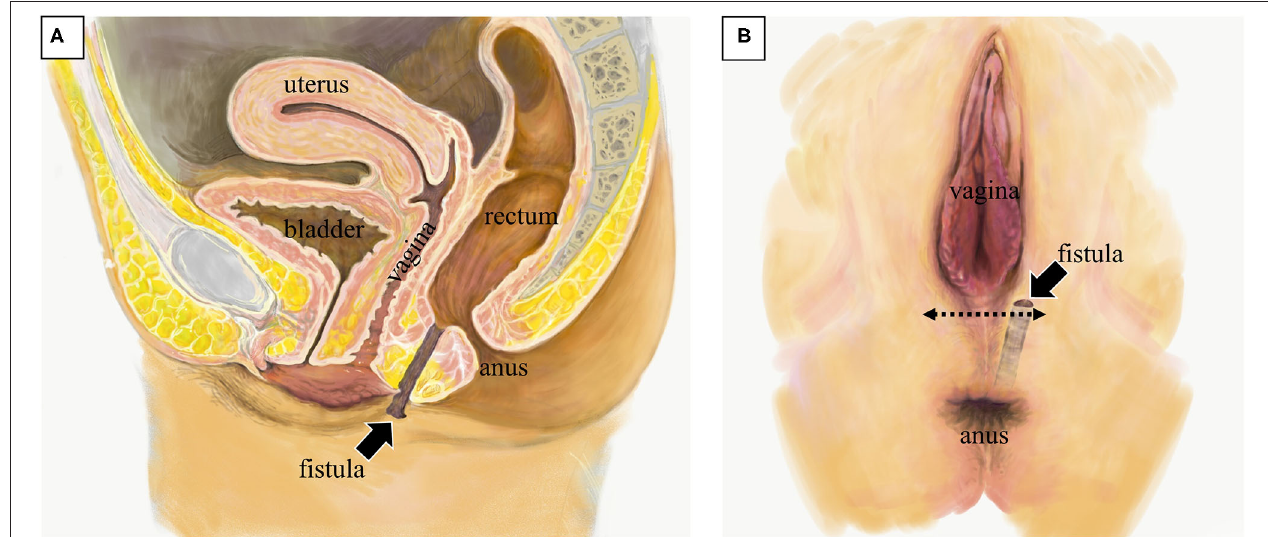
FIGURE 2 | Anatomical schema of the rectoperineal fistula. (A) Sagittal image showing the position of fistula tract (arrow). (B) Image of perineal surface. The fistula opened nearby the vaginal orifice. Perineal approach with transverse incision was placed at the surgery (dotted